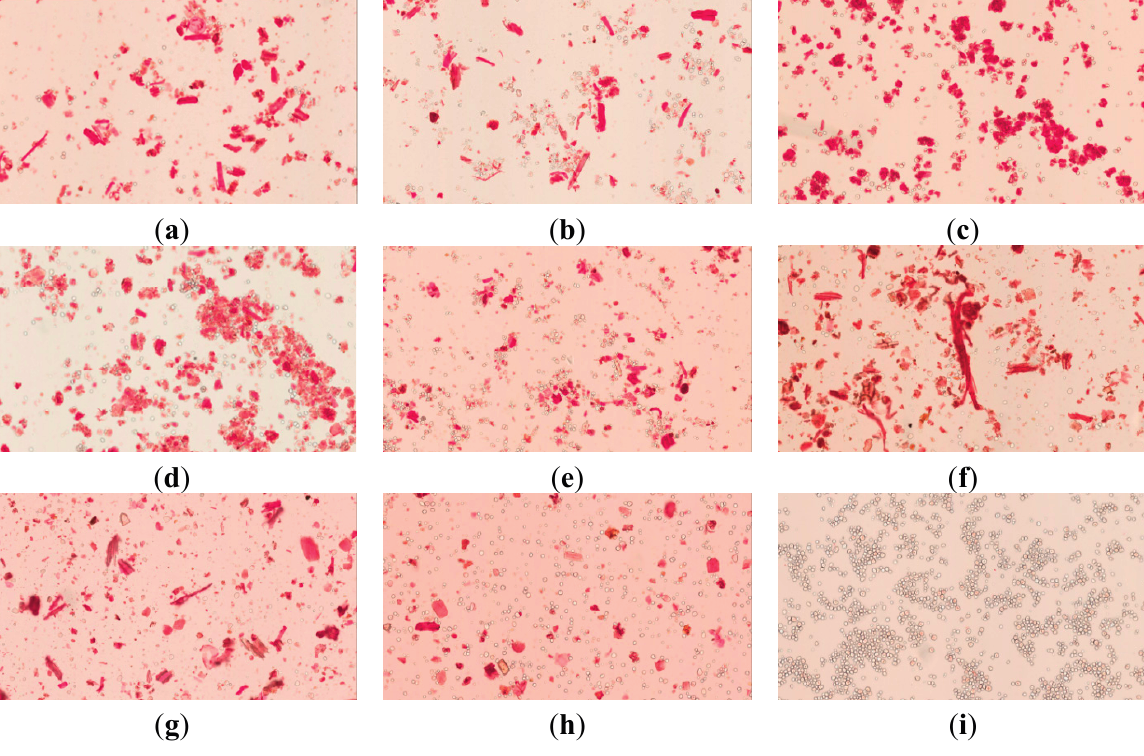
Figure 3. ( a ) Light microscopy images of Congo red stained samples: ( a ) brand A; ( b ) brand B; ( c ) brand C; ( d ) brand D; ( e ) brand E; ( f ) herbal powder; ( g ) herbal